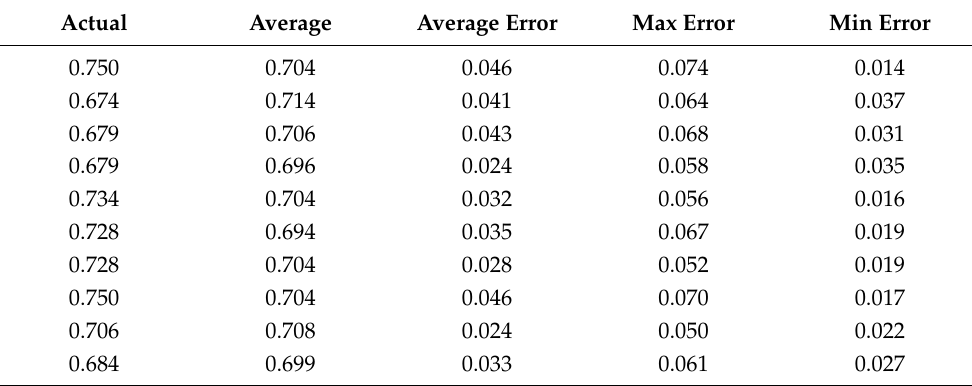
Table A17. Set 1, trials 11–20 data (single 0.5 PR value).